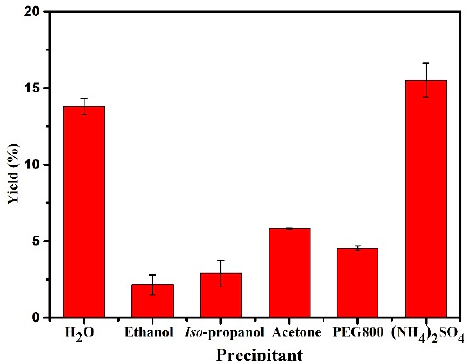
Figure 5. Effect of various precipitant types on the activities of magnetic CALB CLEAs. Reactions performed with 5 mg magnetic CALB CLEAs and 2 mL of n-hexane containing 0.2 mmol of 2-phenylethanol and 0.4 mmol of vinyl acetate at 50 °C for 72 h.